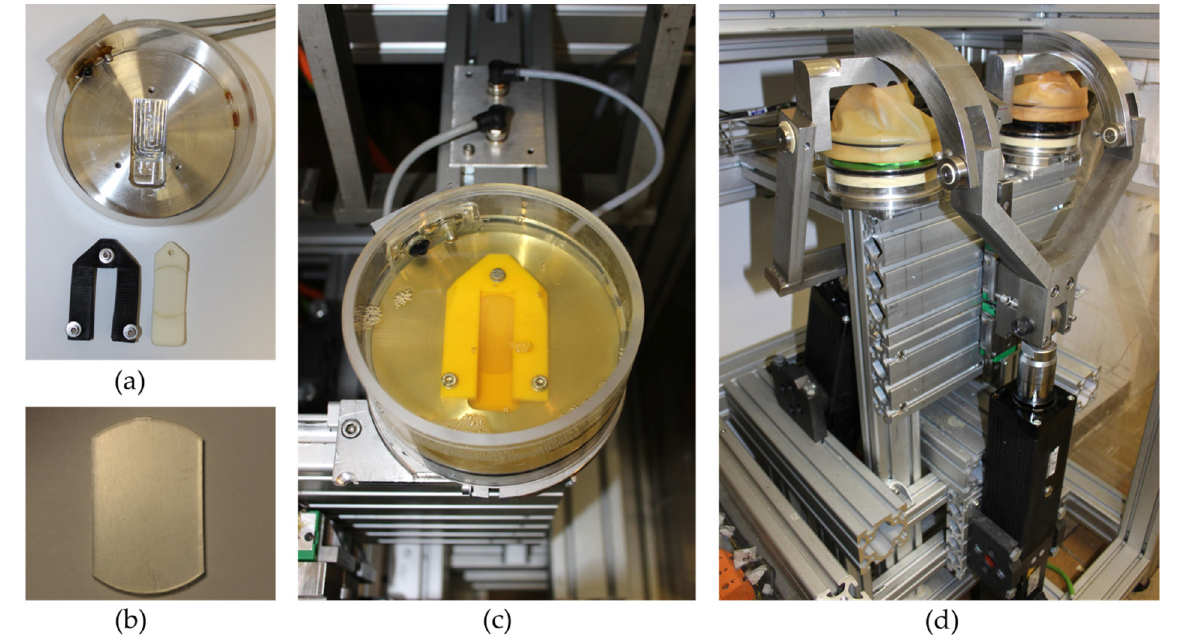
Figure 3. Setup of the rolling-sliding test bench. ( a ) Testing chamber with the sample clamp (black) and sample holder (white), ( b ) prepared polyurethane (PU) sample for testing, ( c ) tempered testing chamber with the fixed PU sample (yellow clamp) in test fluid, and ( d ) rolling-sliding test bench with two testing stations.